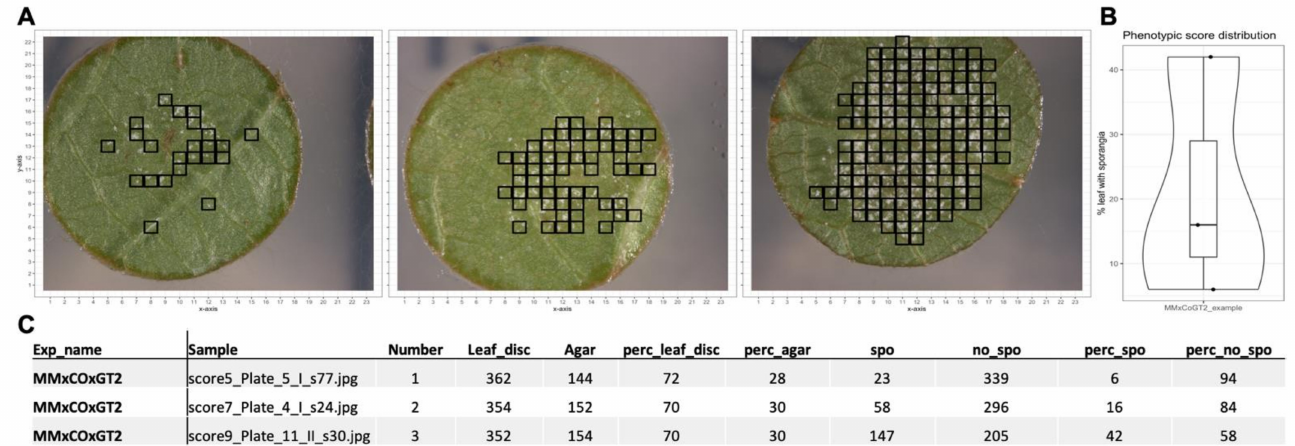
Figure 8. Example results from the leaf disc scoring pipeline. ( A ) Original RGB images with indicated leaf disc slices classified as “with sporangiophores”. ( B ) Overview of calculated percentage leaf disc areas for the analyzed set of images. ( C ) Tab delimited table output of the leaf disc scoring pipeline that can easily be integrated in downstream analyses. (Exp_name— experiment name, Sample—Sample id used in the analysis, Number—serial number, Leaf_disc—slices identified as